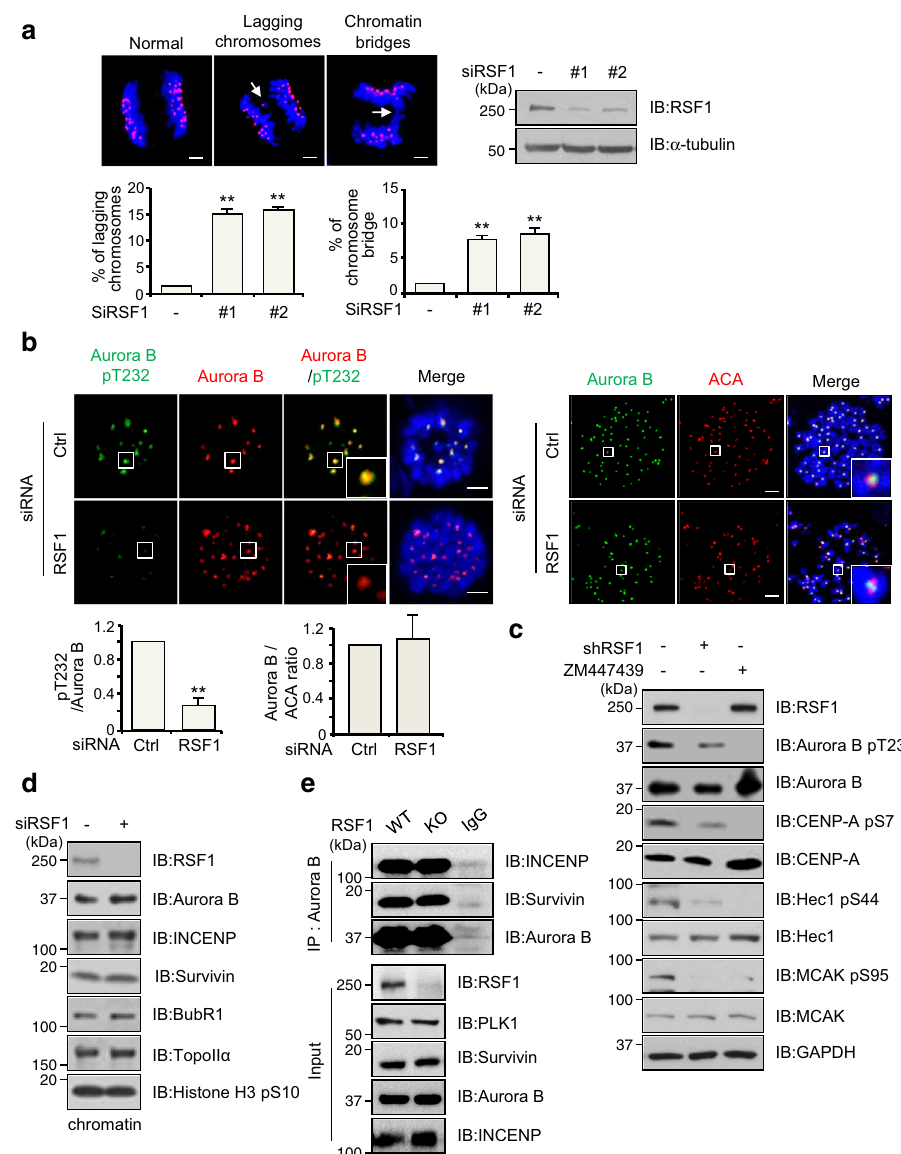
Fig. 1 RSF1 is necessary for the Aurora B kinase activity. a Percentage of anaphases from RSF1 siRNA-expressing cells that display anaphase bridges or lagging chromosomes. These cells arrested at anaphase were stained with DAPI (blue) and ACA (red). Bars represent mean ± SEM from three independent experiments; siCtrl n = 252, siRSF1#1 n = 268, siRSF1#2 n = 172 cells. ** p < 0.005 vs. control siRNA by two-sided unpaired Student ’ s t -test. Scale bar, 5 μ m. b HeLa cells were transfected with RSF1 siRNA. Floating mitotic cells were obtained after nocodazole treatment for 4 h and subjected to immuno fl uorescence stained with the indicated antibodies. Nucleus was stained with DAPI (blue). The graphs represent mean ± SEM from three independent experiments showing relative signal intensity of Aurora B-pT232 (siCtrl n = 42 and siRSF1 n = 57) or Aurora B (siCtrl = 25 and siRSF1 n = 34) at the kinetochores. ** p < 0.005 vs. control siRNA by two-sided unpaired Student ’ s t -test. Scale bar, 5 μ m. c The HeLa cell lysates were obtained from stably expressing the control or RSF1 shRNA and control shRNA cells treated with ZM447439, Aurora B inhibitor, was treated with nocodazole for 16 h. The mitotic cell lysates were subjected to immunoblotting with indicated antibodies. d HeLa cells transfected with RSF1 siRNA were treated with nocodazole for 16 h. Chromatin-bound fraction was subjected to immunoblotting with the indicated antibodies. e Mitotic RSF1 WT or RSF1 KO HeLa cell lysates were immunoprecipitated with anti-Aurora B antibody (endogenous) or mouse IgG antibody and followed by immunoblotting with indicated antibodies. Data of c – e are representative of three independent experiments. Source data are provided as a Source Data fi